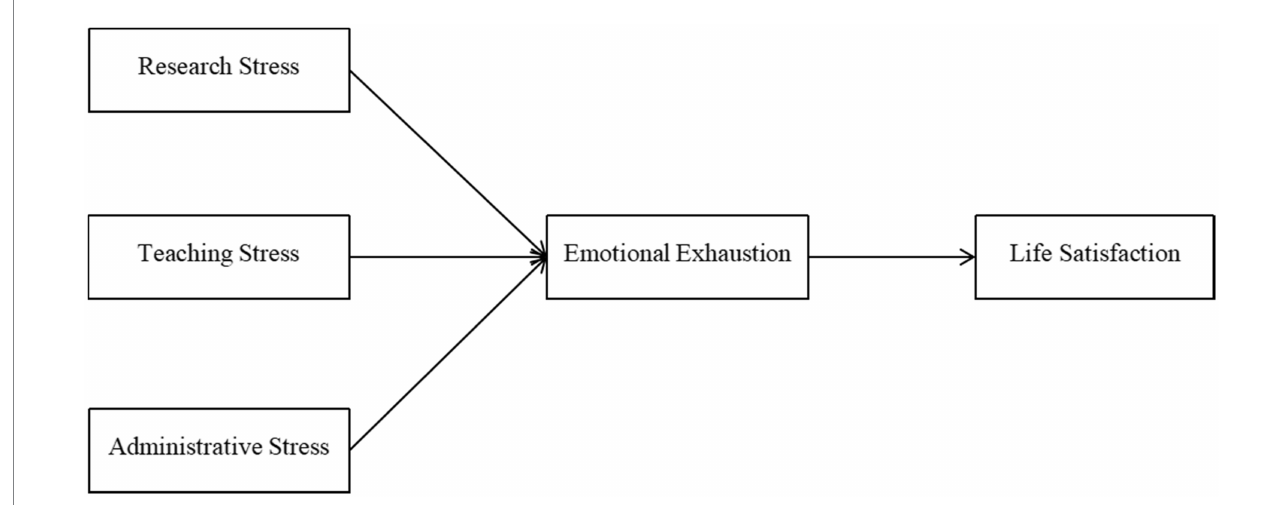
FIGURE 1 Theoretical model in this